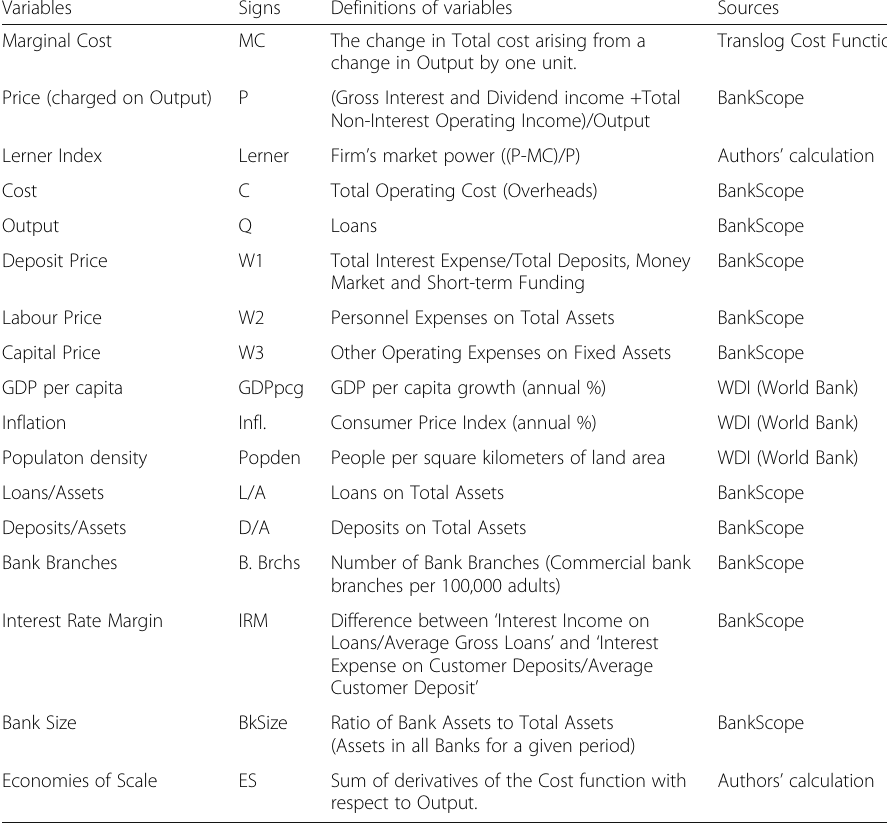
Table 5 Definitions of